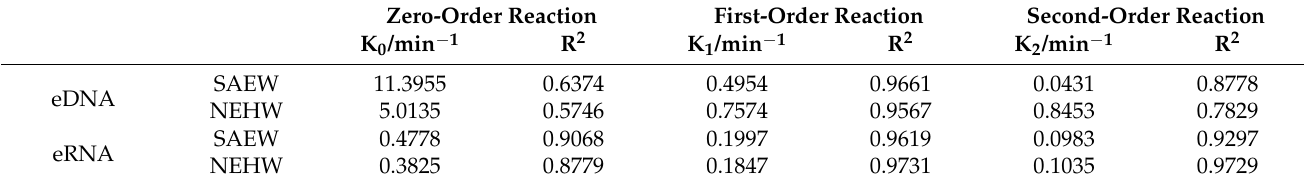
Table 4. Degradation rate and reaction order of SAEW and NEHW treated at different